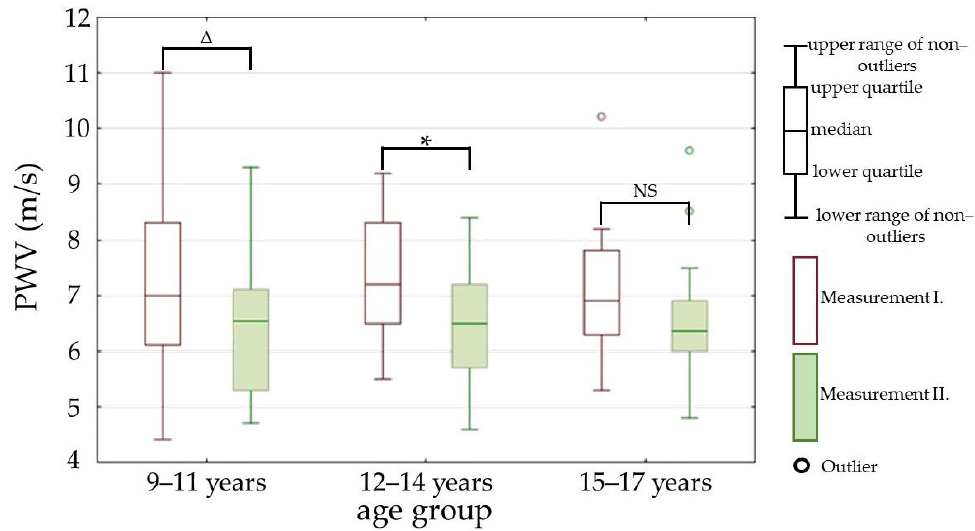
Figure 4. Pulse wave velocity (PWV) in measurements I. and II. Measurement I.—at the beginning of the one-month stay in the children’s hospital; measurement II.—at the end of the one-month stay in the children’s hospital; *— p value is less than 0.01; ∆ — p value is less than 0.05; NS—non-significant; p value—statistical evaluation of the differences between the measurements I. and II., Wilcoxon signed-rank test (paired test).